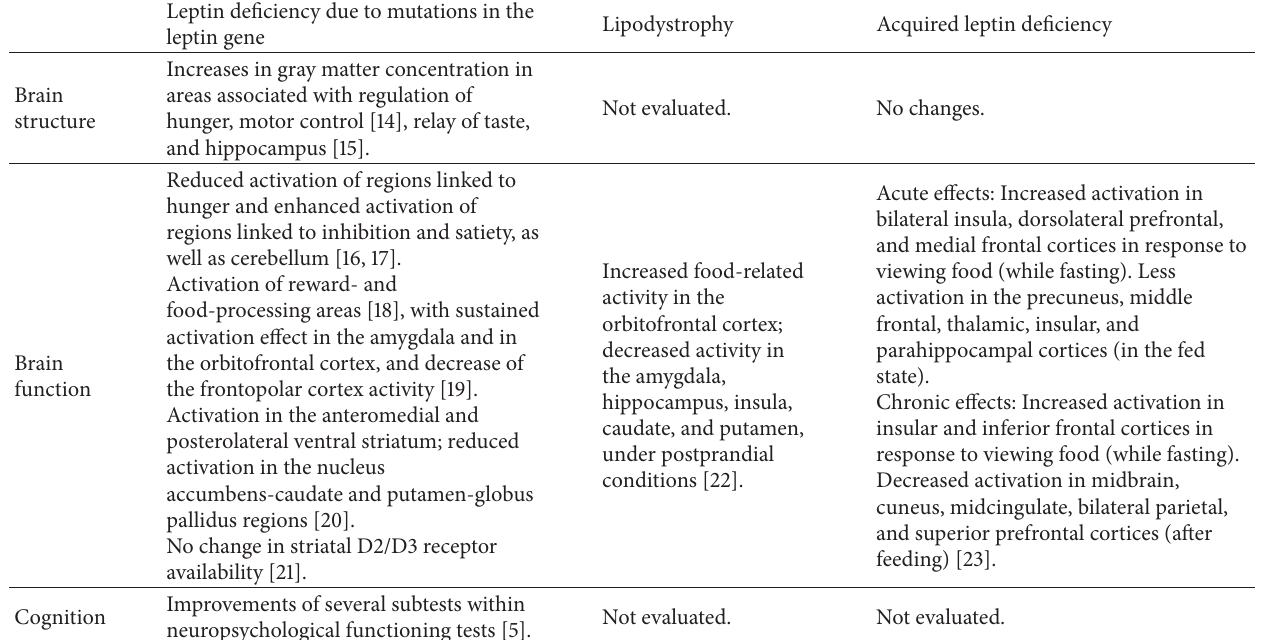
Table 1: Effects of leptin replacement therapy on neural plasticity, neural function, and